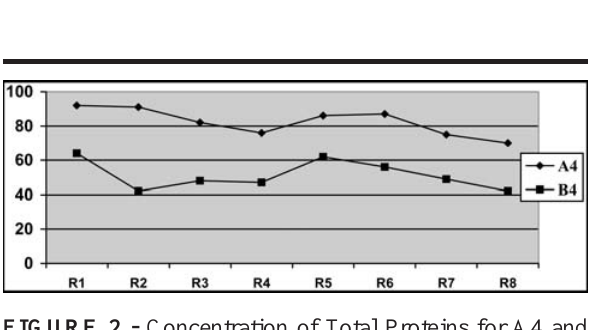
FIGURE 2 - Concentration of Total Proteins for A4 and B4 subgroups